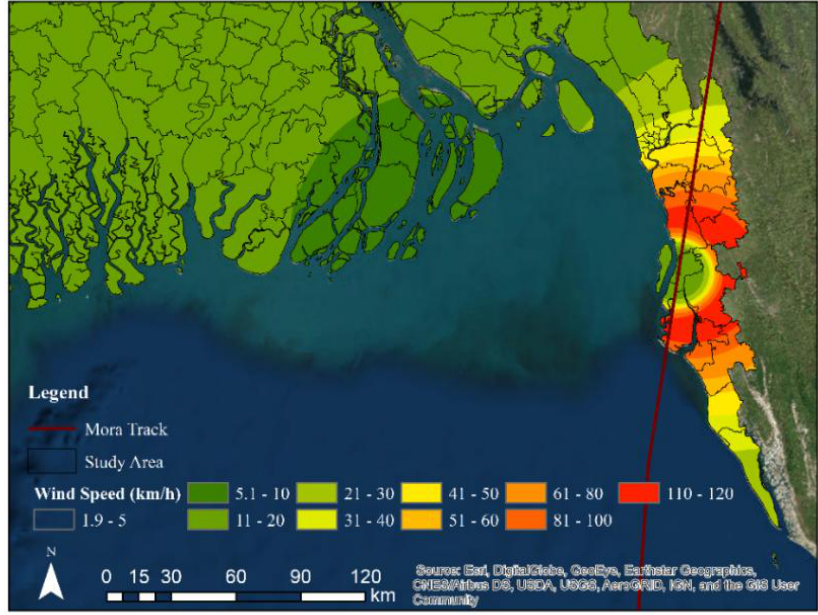
Figure 10. Distribution of wind speed during TC Mora.